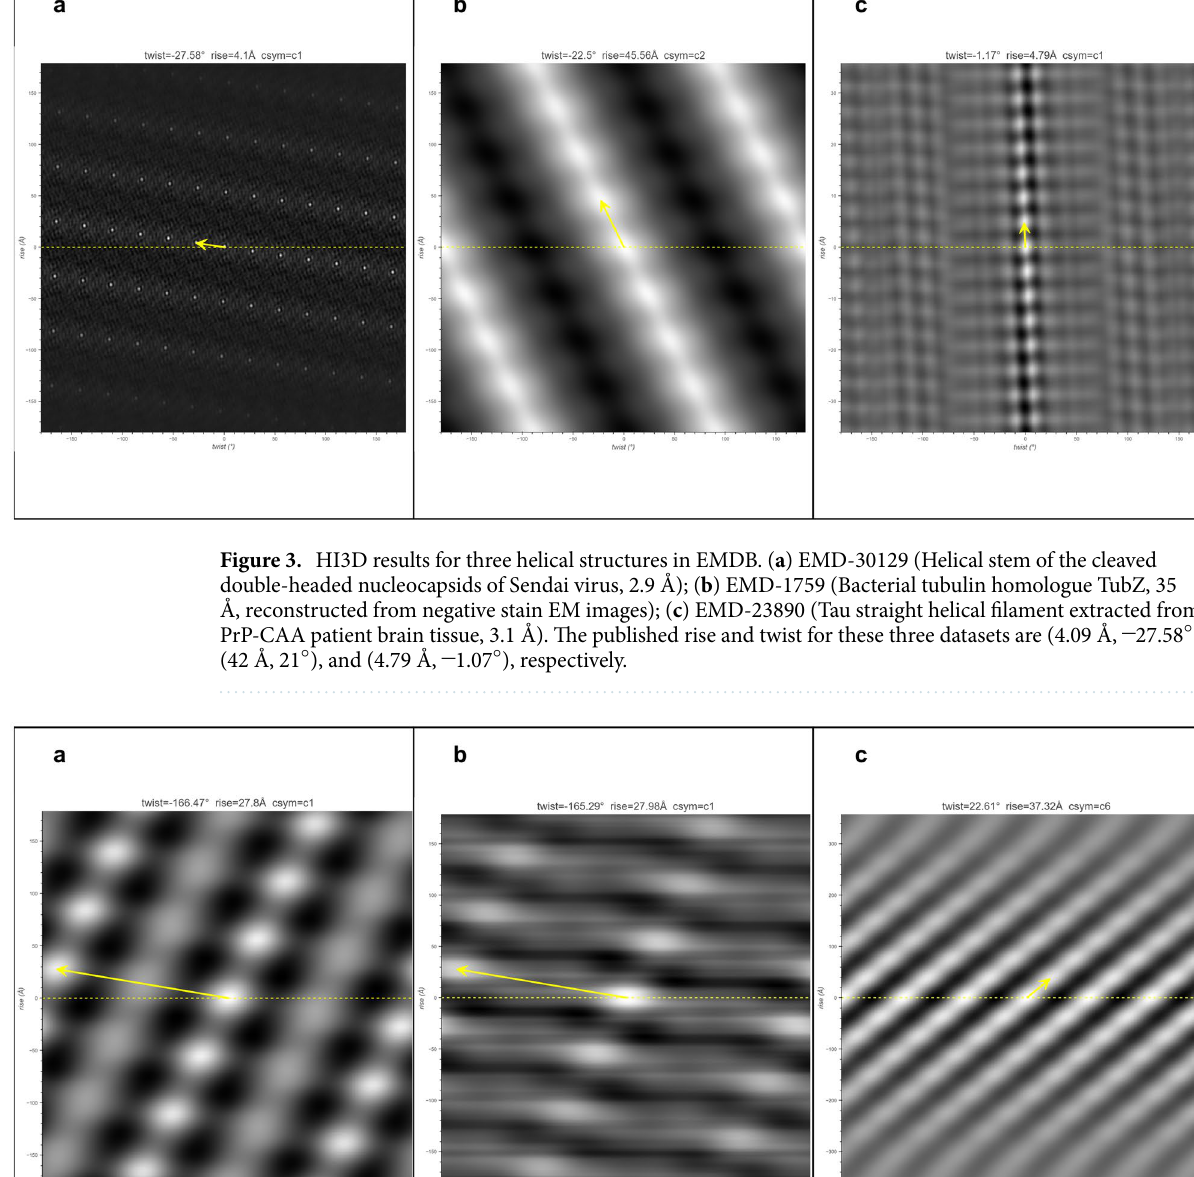
Figure 4. HI3D results for three subtomogram averages in EMDB. ( a ) EMD-12289 (in situ actomyosin, 10.2 Å); ( b ) EMD-12293 (in situ I-band thin filament including troponin complex, 19.8 Å); ( c ) EMD-8601 (in situ type VI secretion system, 24